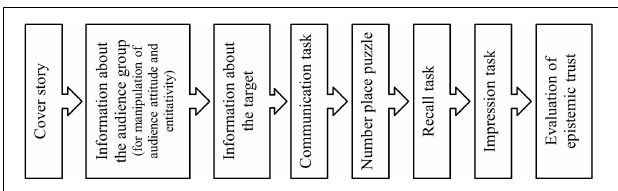
FIGURE 1 | The flow of the experimental